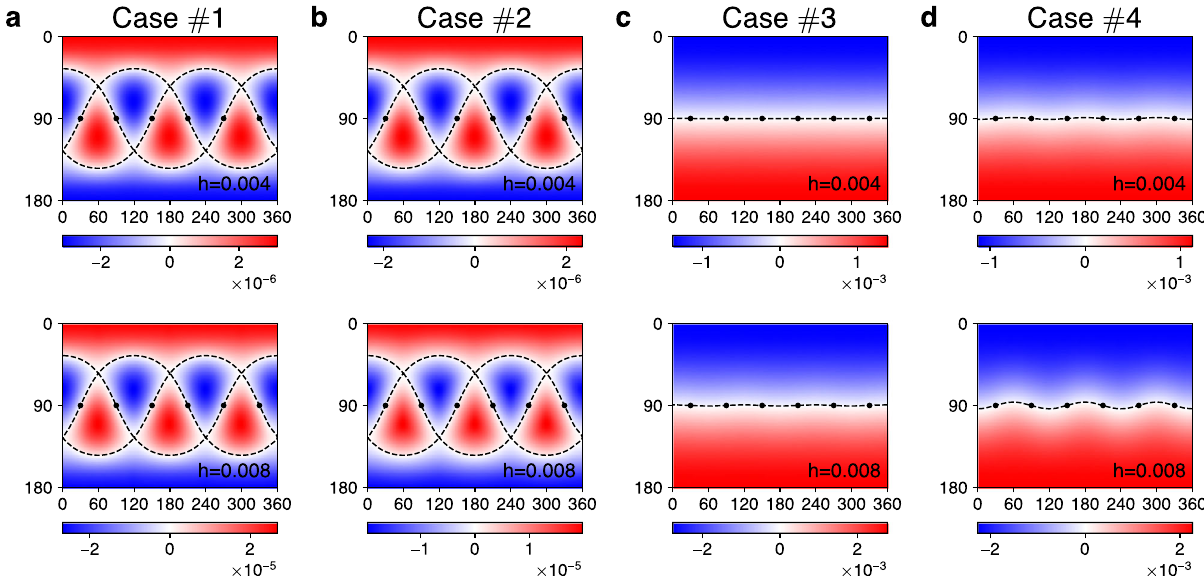
Fig. 3 Field evolutions of the zero lines. Color maps of the chirality χ ED ( h ) on the plane of the fi eld angles ( θ , ϕ ) with increasing magnetic fi eld h = 0.004, 0.008 (horizontal axis: ϕ [°], vertical axis: θ [°]). The dashed lines highlight the zero lines χ ED ( h ) = 0, and the black dots mark the bond directions. The parameter sets used in the four cases ( # 1~4) are listed in Table